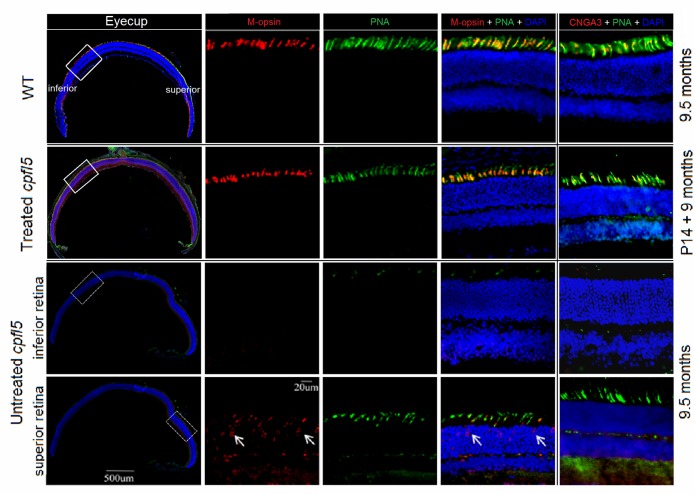
Long-term preservation of retinal M-opsin and CNGA3 after treatment with AAV8 (Y447, 733F + T494V)-IRBP/GNAT2-Cnga3.At 9 months after P14 treatment, cpfl5 retinal immunostaining revealed normal expression and the cone OS distribution (merge) of M-opsin, compared with WT controls. In untreated cpfl5 eyes, the inferior retinas had little M-opsin and cone specific PNA staining, whereas the superior retinas showed mislocalization of M-opsin within residue cones (arrows). In WT and treated cpfl5 retinas, M-opsin was located in the cone OS. Red: M-opsin or CNGA3 staining; Green: cone-specific PNA staining; Blue: nuclei staining with DAPI (4′,6-diamidino-2-phenylindole). P, postnatal day.